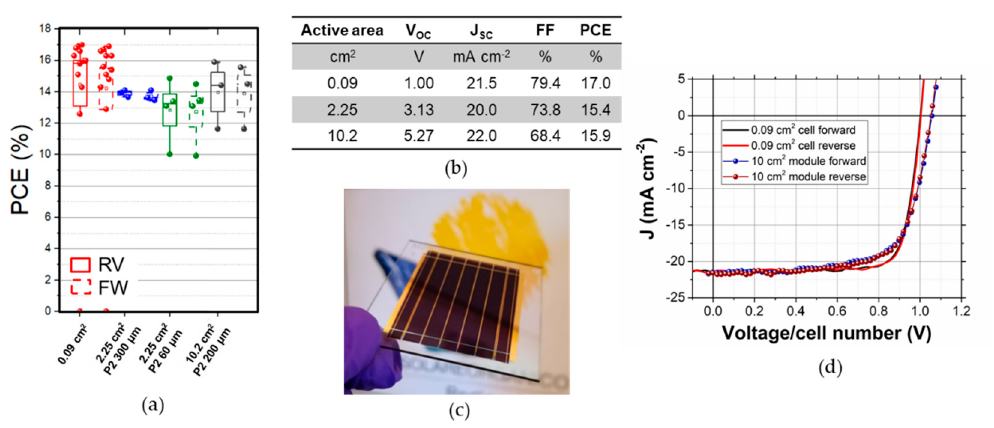
Figure 6. ( a ) Box plot of the active area efficiencies of the devices fabricated for this work; ( b ) Summary table with the PV parameter of the best device per each size; ( c ) Picture of the 10.2 cm 2 module; ( d ) JV curve (voltage is divided by number of cells) of the best 0.09 and 10.2 cm 2 device.